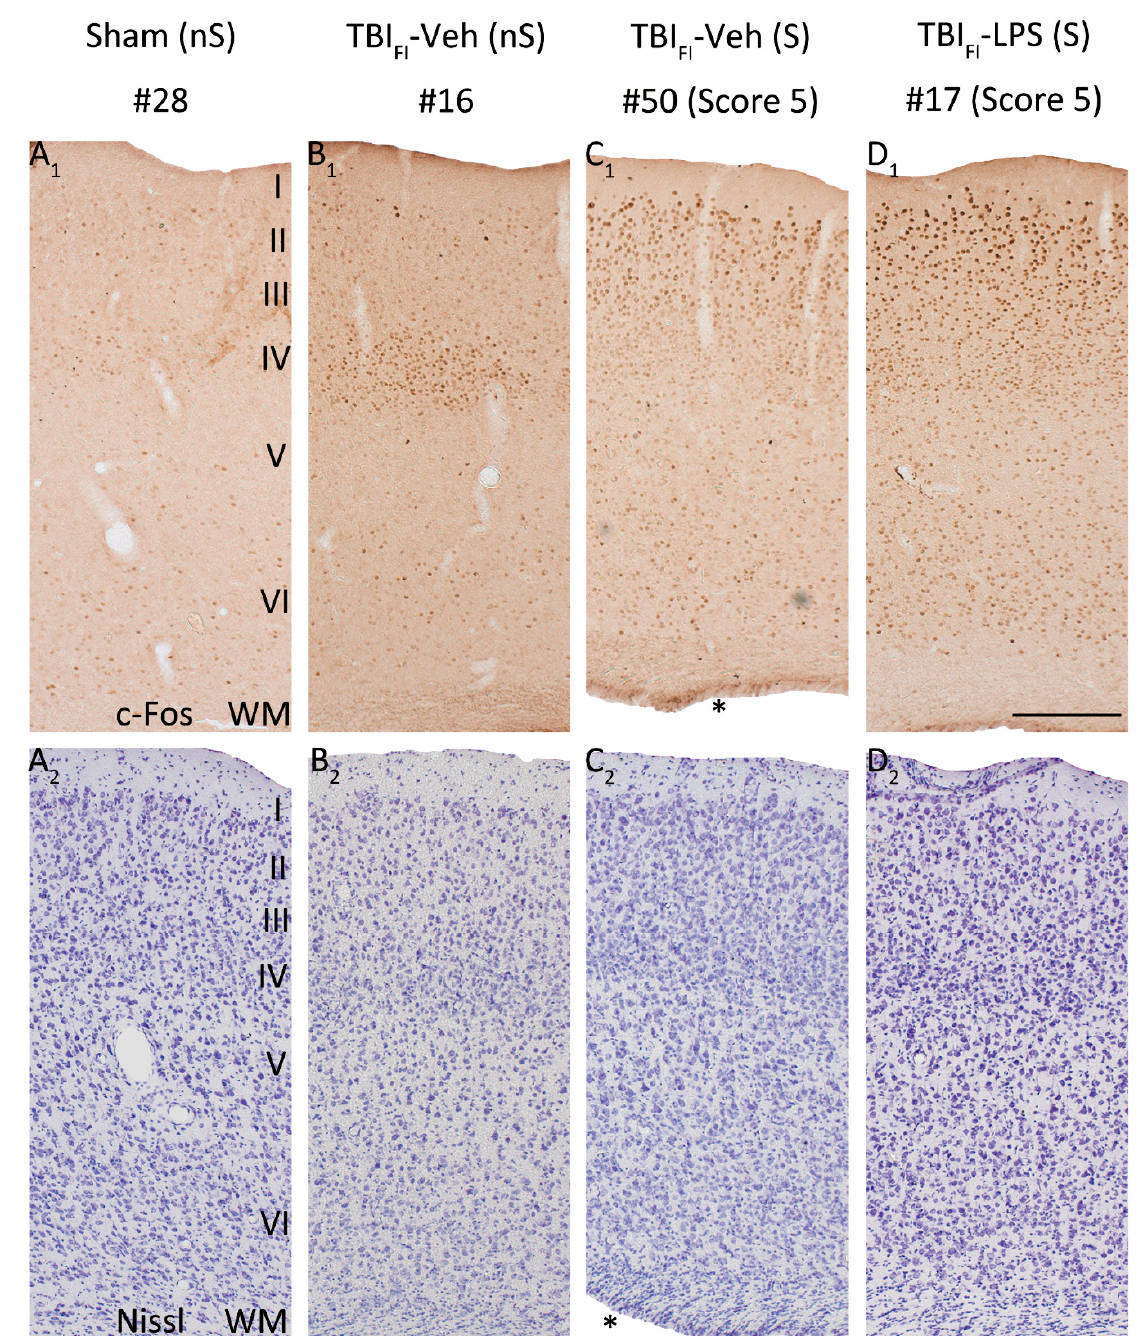
Figure 6. LPS enhances the seizure-induced c-Fos expression and changes its pattern in the rostromedial perilesional cortex. Representative high-magnification photomicrographs showing c-Fos immunolabeling ( A 1 – D 1 ) and thionin staining ( A 2 – D 2 ) in the rostromedial perilesional cortex (somatosensory cortex, see Figure 3C) of a vehicle-treated sham-operated rat and a vehicle or LPS-treated injured rat with a TBI FI endophenotype at 2 h after PTZ injection (15 weeks after LPS injection and 23 weeks post-TBI). ( A 1 , A 2 ) A rat from the Sham-Veh group without PTZ-induced seizure (#28). Note the very low c-Fos expression level throughout the cortical layers. ( B 1 , B 2 ) A rat from the TBI FI -Veh group without a PTZ-induced seizure (#16). Note the intense c-Fos labeling in layer IV apparently reporting on the TBI-induced chronic excitability. ( C 1 , C 2 ) A rat from the TBI FI -Veh group with a PTZ-induced seizure (#50, Racine score 5 seizure). Note the intense c-Fos labeling in layers II-III. ( D 1 , D 2 ) A rat from the TBI FI -LPS group with a PTZ-induced seizure (#17, Racine score 5 seizure) with intense c-Fos labeling in layers II-III and scattered immunopositive cells in deeper layers. Note that the occurrence of PTZ-induced seizures changed the overall pattern of perilesional c-Fos expression in TBI animals (with or without LPS). In addition